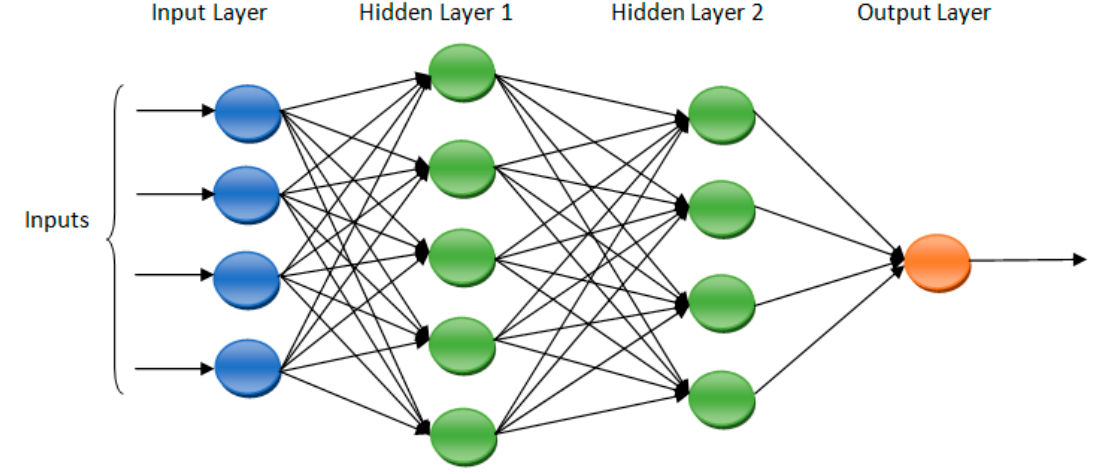
Figure 1. Artificial neural network.